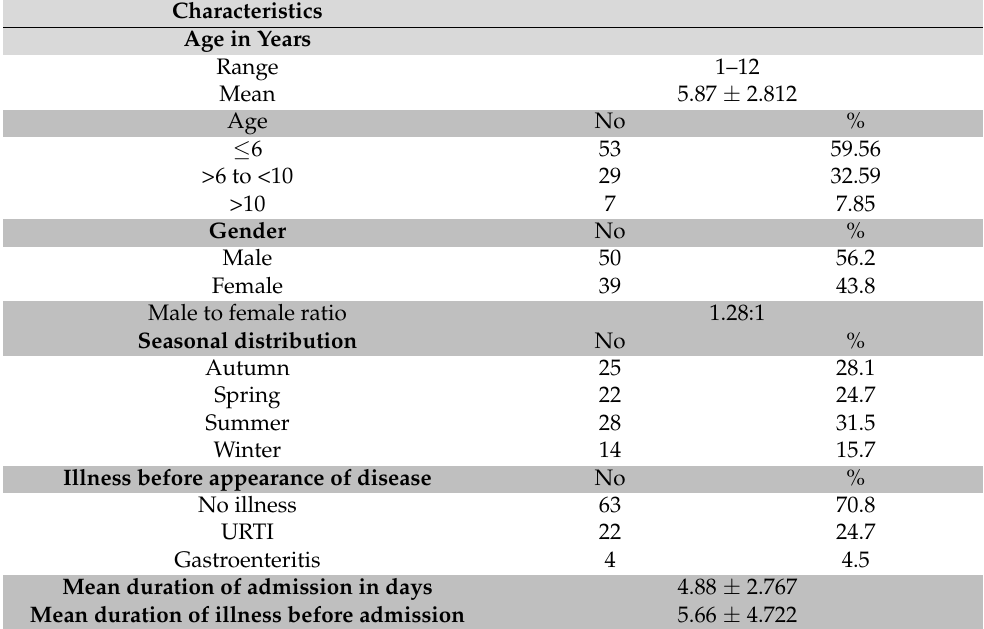
Figure 2. Showing the distribution of IgA vasculitis cases, according to the seasonal occurrence. Table 1. Epidemiologic characteristics in children with IgA vasculitis.